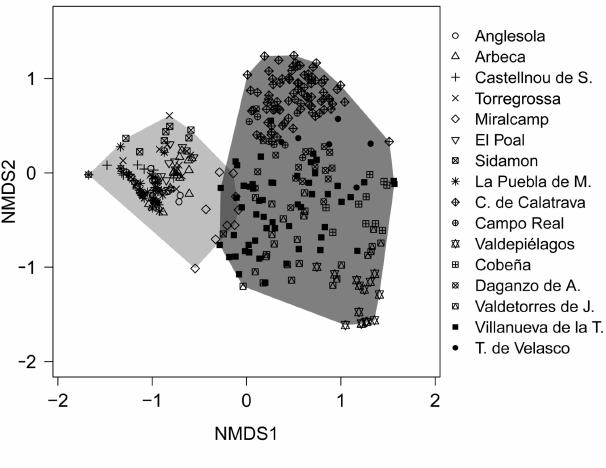
Fig. 2 . Nonmetric multidimensional scaling (NMDS) plot representing diet similarity for dry farmland (dark grey) and irrigated areas (light grey).